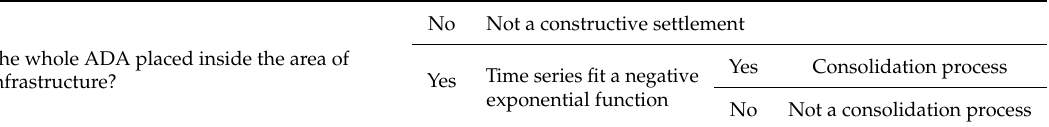
Table 1. Sketch of the algorithm used to ascertain if an ADA corresponds to a constructive or consolidation process. Source: